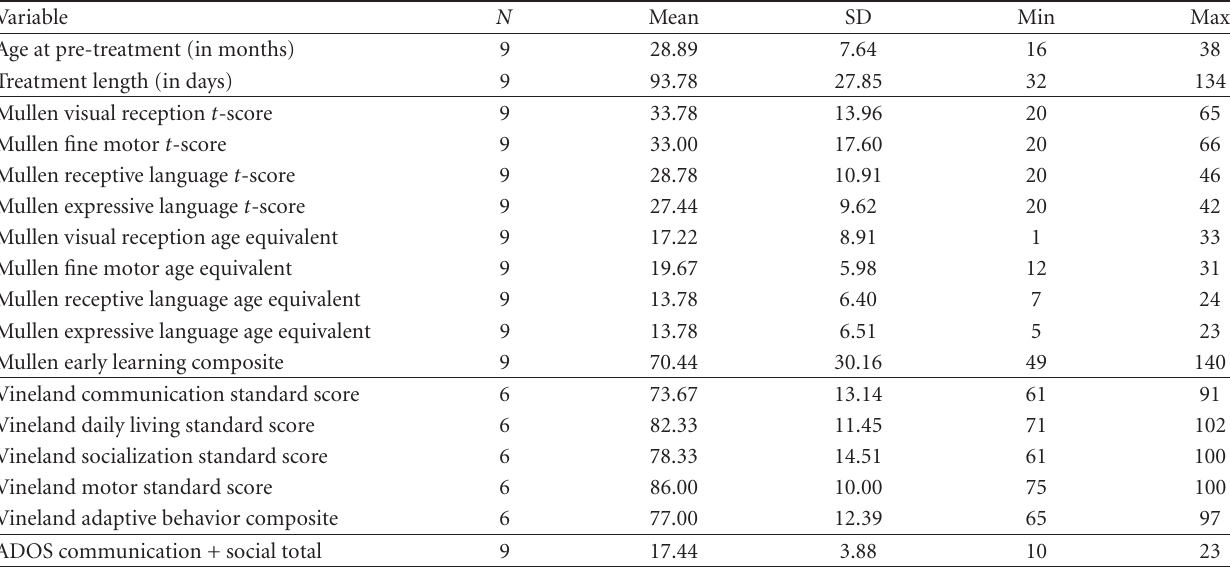
Table 1: Baseline standardized test